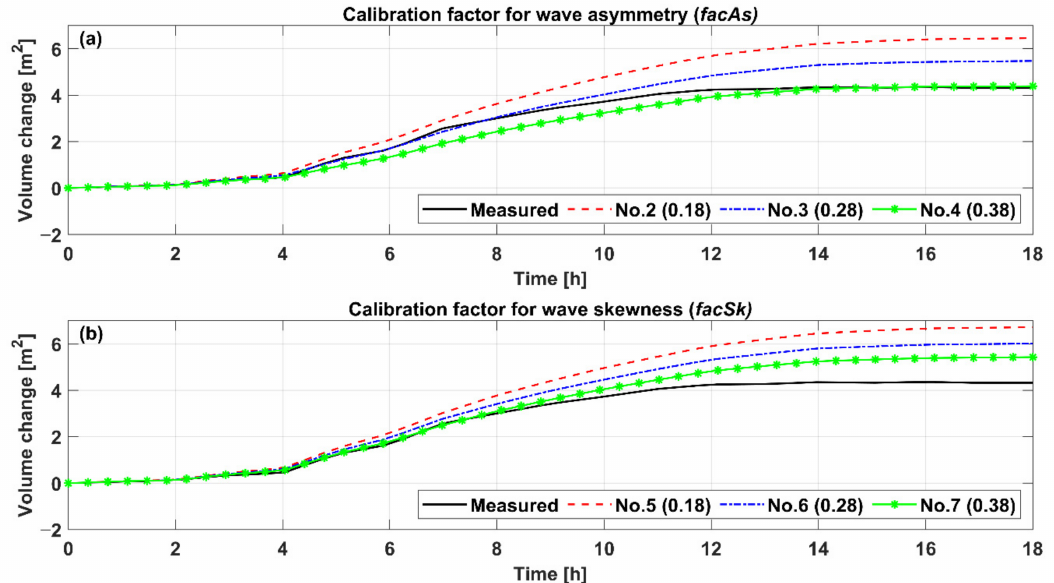
Figure 4. Time-varying volume changes above mean sea level under ( a ) facSk = 0.13 with varying facAs (0.18, 0.28, and 0.38), ( b ) facAs = 0.13 with varying facSk (0.18, 0.28, and 0.38): No. (simulation number in Table 3), Measured (black solid line), 0.18 (red dashed line), 0.28 (blue dash-single dotted line), and 0.38 (green solid line with star